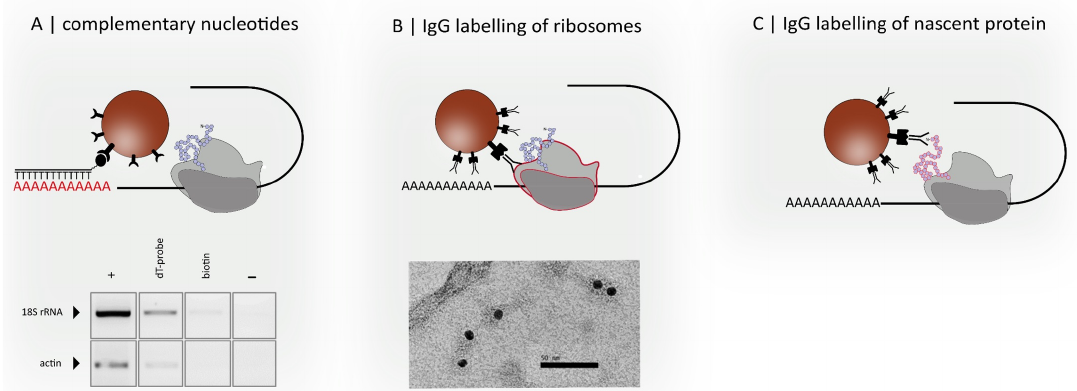
Figure 2. ( A ) Labelling and isolation of specific transcripts by complementary nucleotide sequences. ( B ) Labelling of ribosomes with antibodies (IgG) and immunogold labelling of polysomes. ( C ) Labelling of nascent proteins with antibodies. Shown results are own data. See Appendix A Material and Methods A2 and A3 for detailed